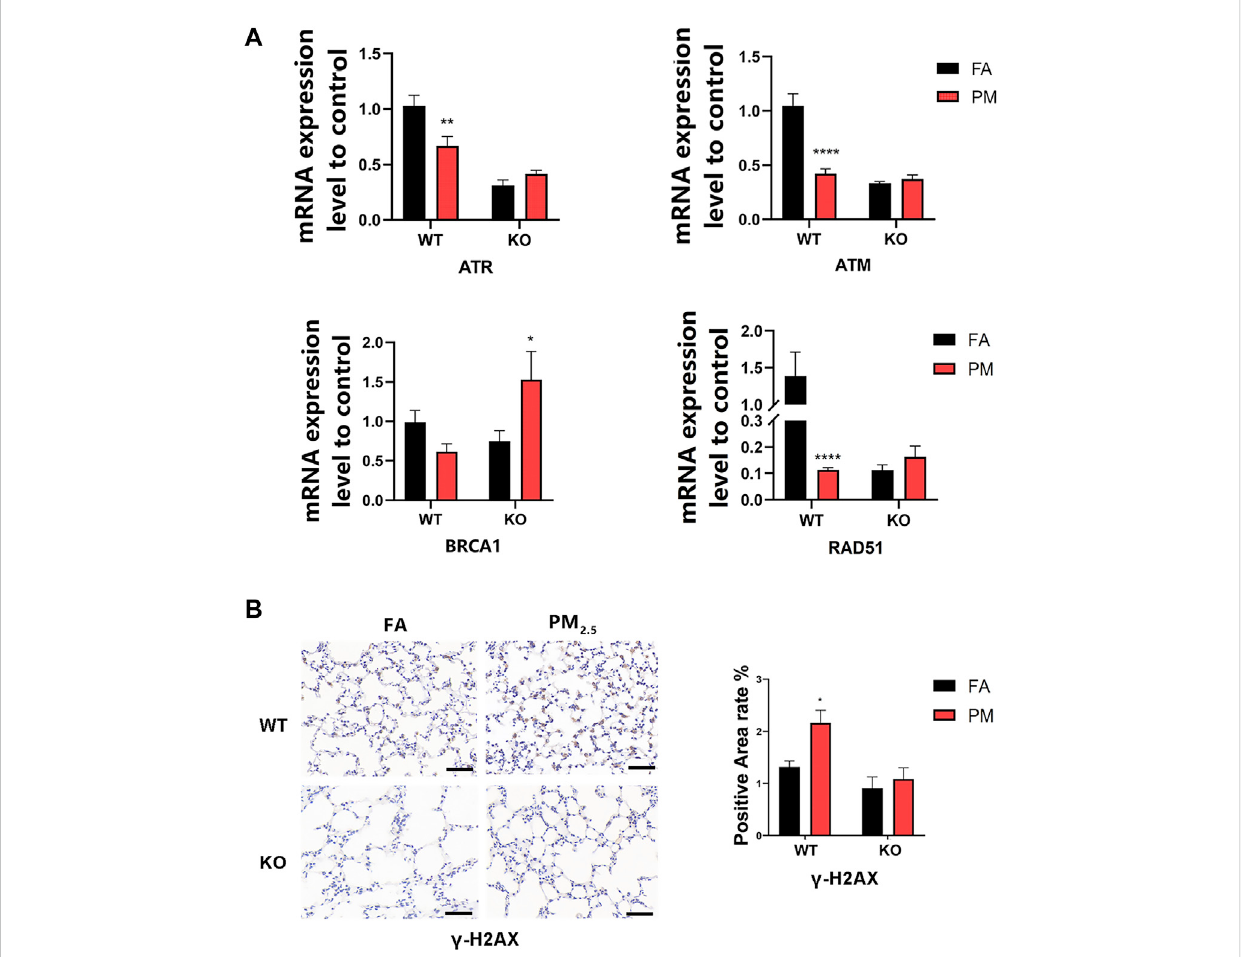
Effects of PM 2.5 exposure on ATR pathway-related factors. (A) mRNA expression of ATR pathway-related indicators. n = 3 in each group. Data were mean ± SEM, * p < 0.05, ** p < 0.01, **** p < 0.0001. (B) γ -H2AX expression level in mice lung tissue was detected by immunohistochemistry and